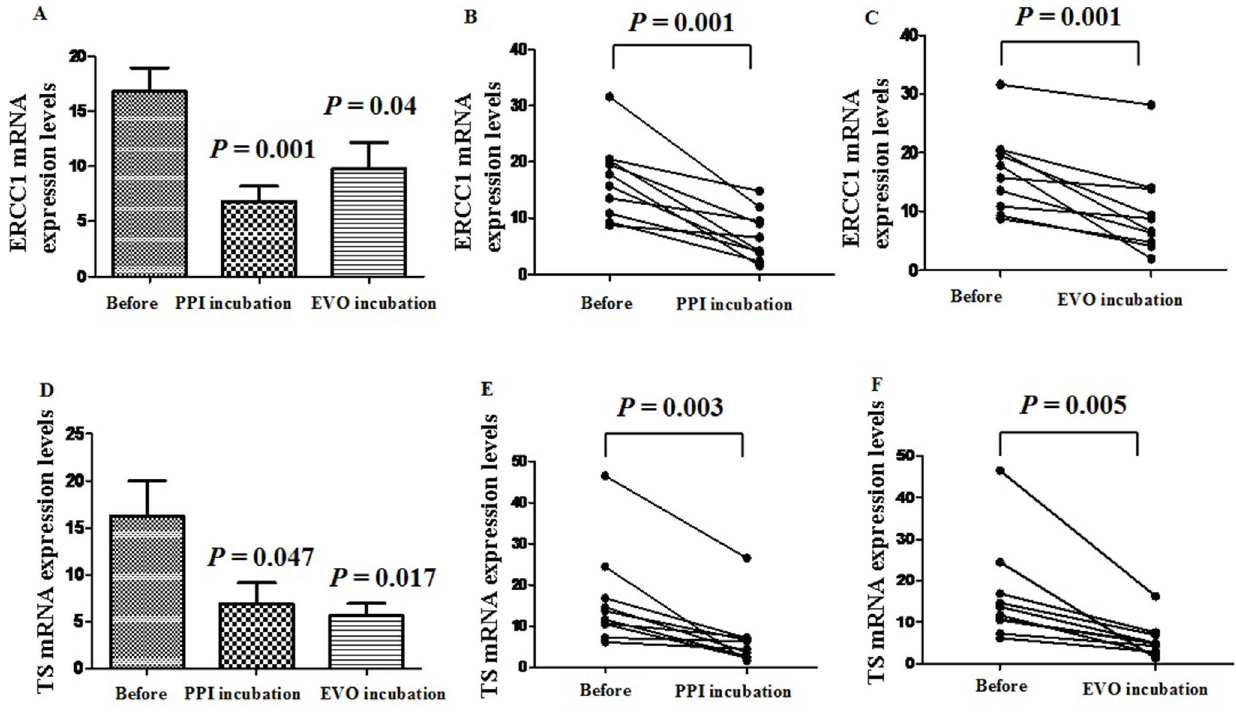
Figure 7. The effects of PPI and EVO on mRNA expression levels of ERCC1 and TS.